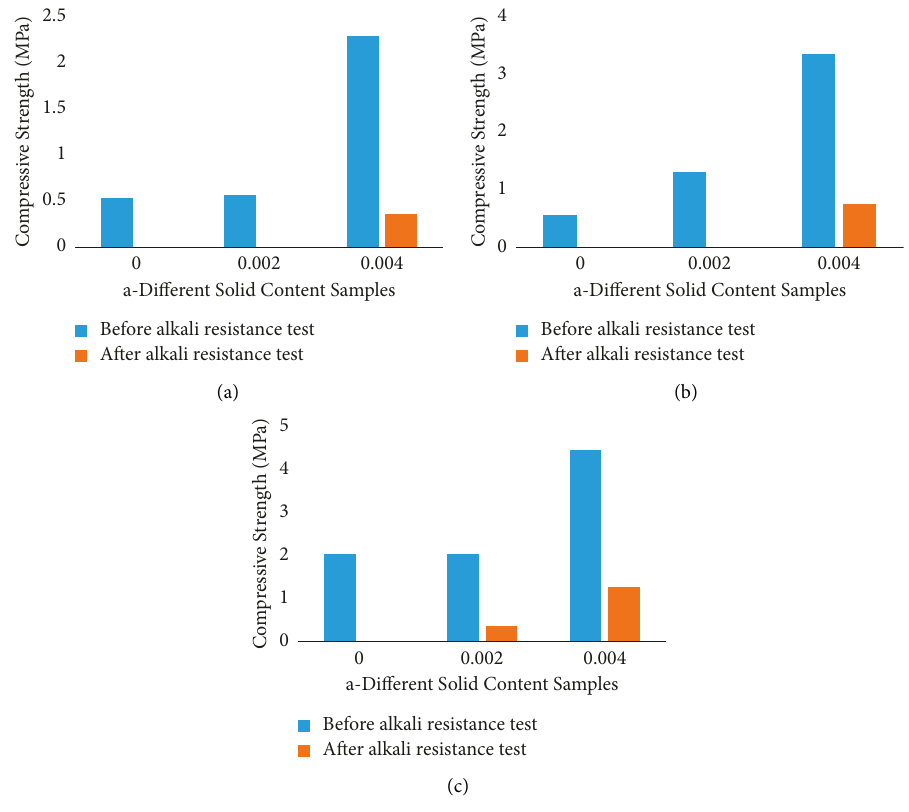
Figure 8: Alkali resistance strength of cured